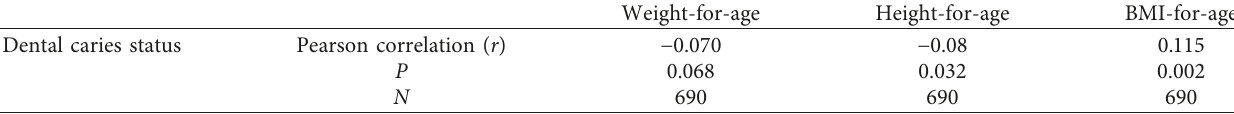
Table 6: Correlation between dental caries and malnutrition